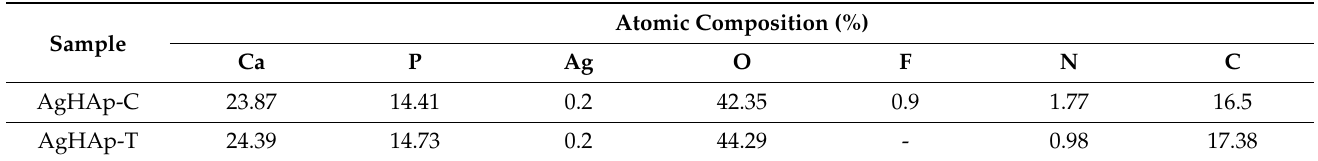
Table 1. The elemental composition estimated from EDS analysis. Atomic Composition Sample